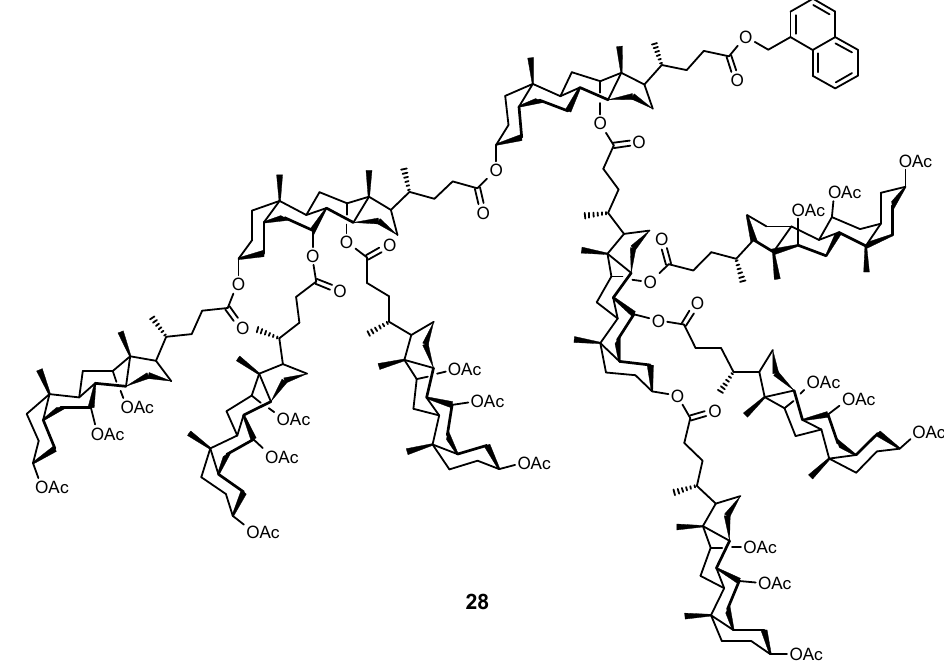
Figure 17. A bile acid-based chiral dendron